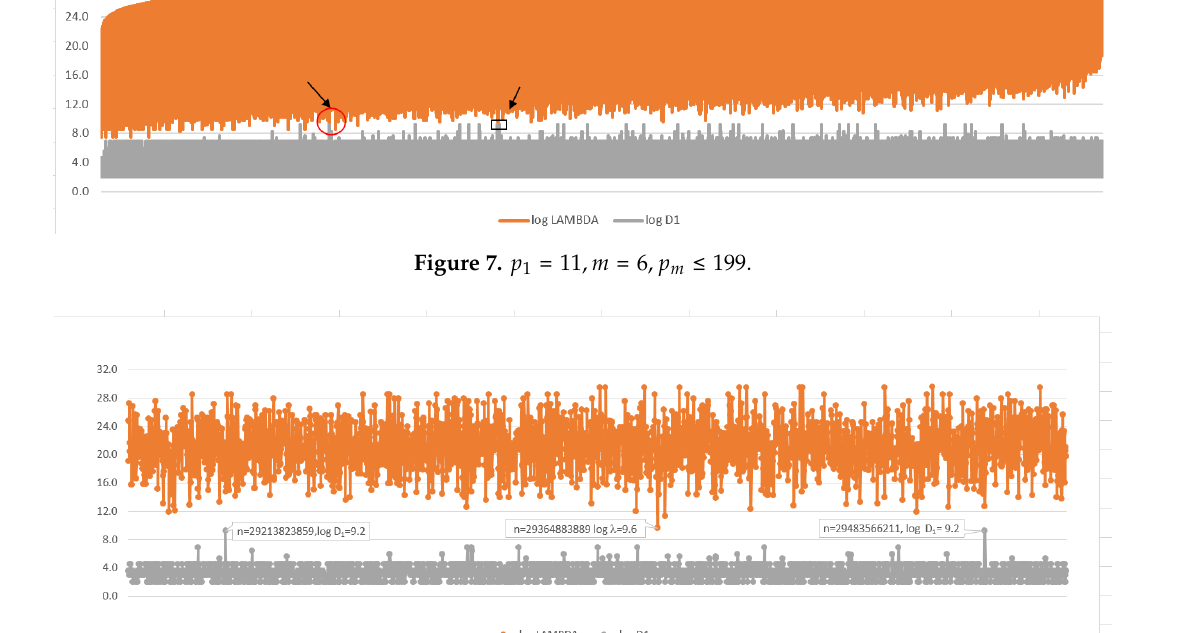
Figure 8. Detail from p 1 = 11, m = 6, p m ≤